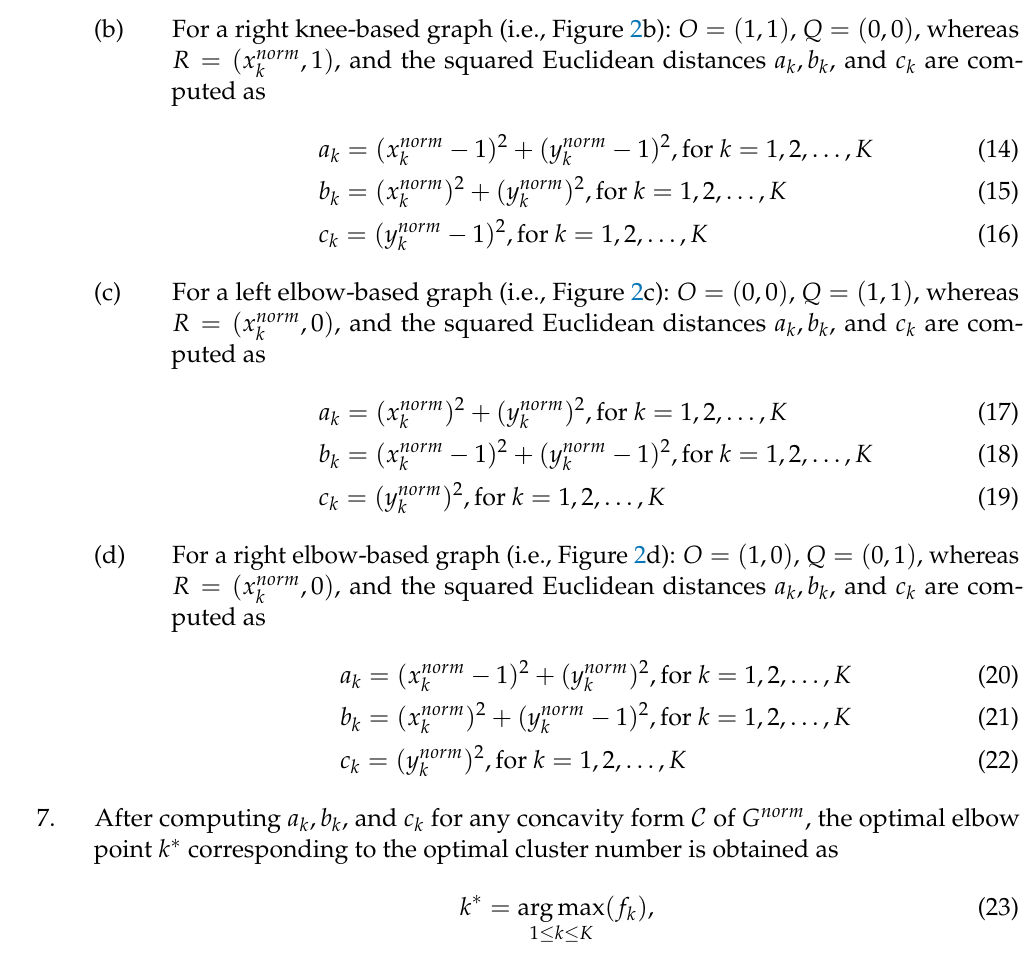
For a left elbow-based graph (i.e., Figure 2c): O = ( 0, 0 ) , Q = ( 1, 1 ) , whereas R = ( x norm , 0 ) , and the squared Euclidean distances a k , b k , and c k are com- k puted as